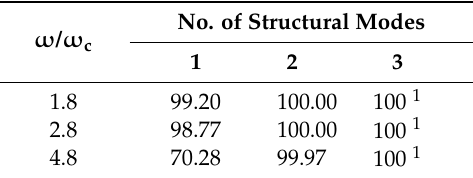
Table 3. Structural mode convergence study (1st level solution, number of acoustic modes = 4, l = 5 a , γ = 4). ω / ω c